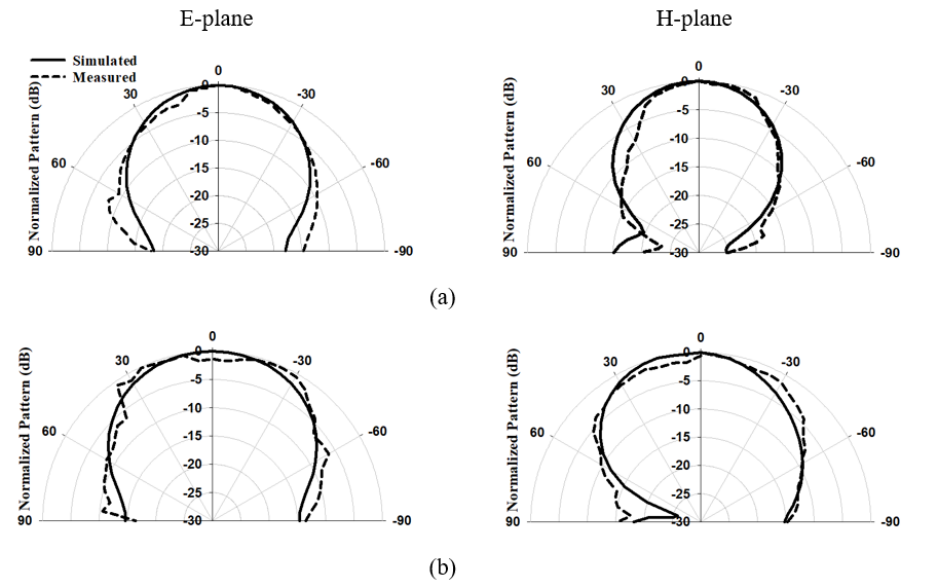
Figure 5. The E and H planes radiation patterns of a hemispherical DRA with an outlined position on the ground plane ( a ) 22.7 GHz ( b ) 27